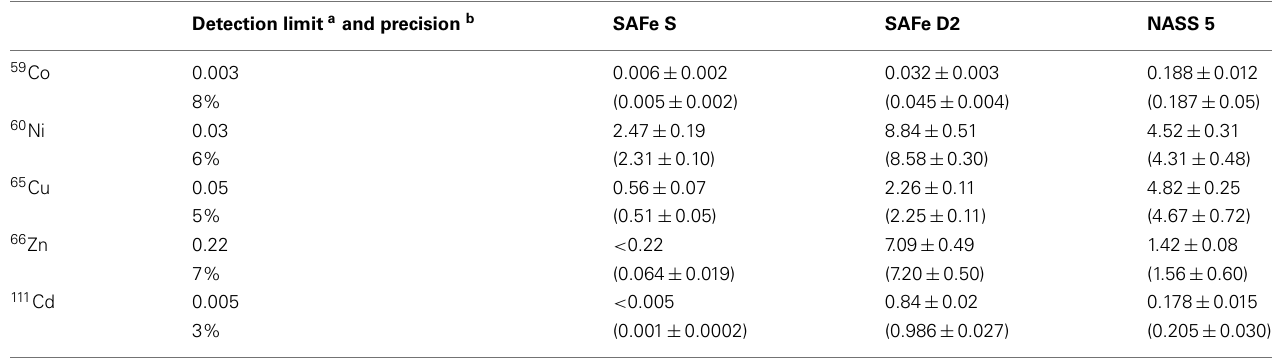
Table 2 | Figures of Merit for FI–SPE–ICP-MS